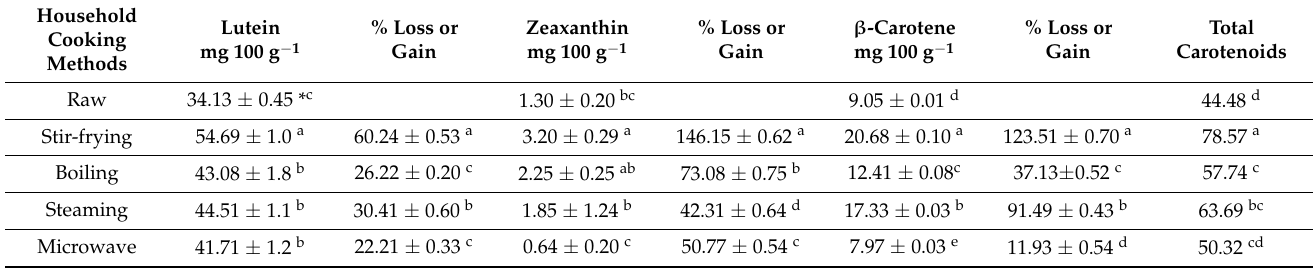
Table 2. The effects of different household cooking techniques on carotenoid components of African pumpkin leaves ( Momordica balsamina